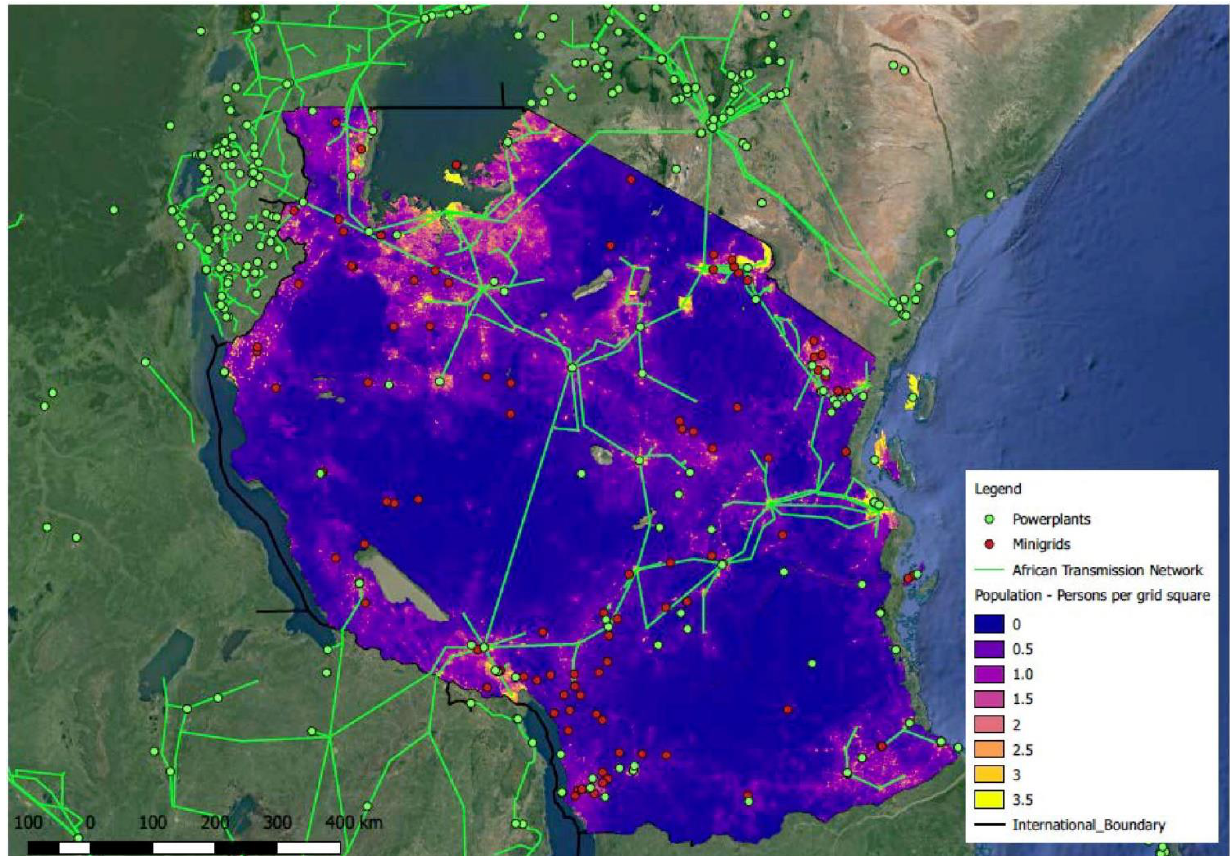
Figure 1. Population distribution in Tanzania in relation to existing power grid and mini grids [11].